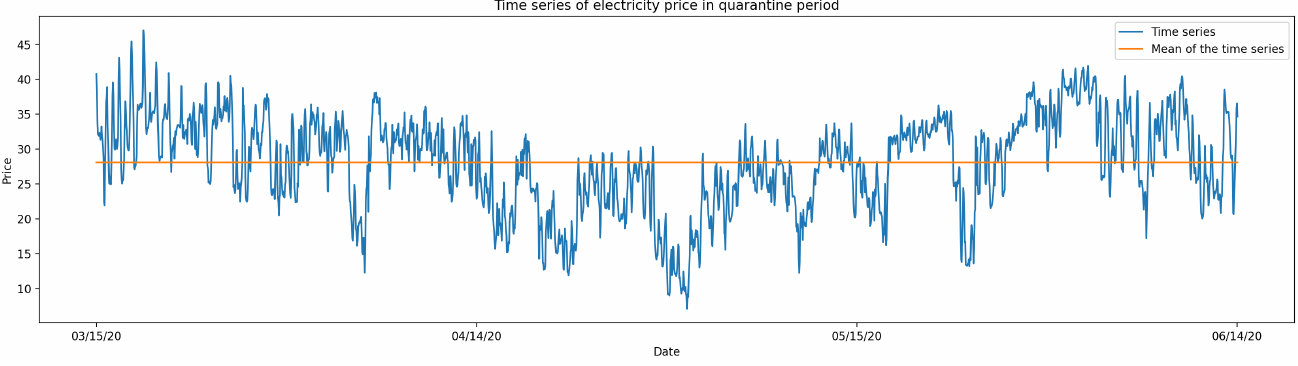
Figure 5. Time series of quarantine period. On the x-axis we can see that this period covers electricity prices between 15 March 2020 and 15 June 2020. The horizontal line shown indicates the average for this period, which is 28.09.